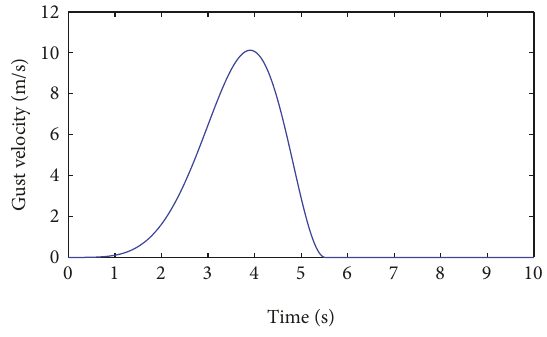
Figure 3: Vertical gust